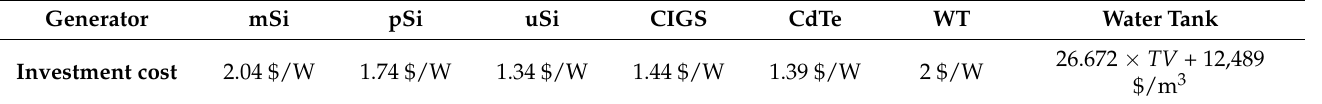
Table 3. Investment costs for the different PV cell technologies, wind turbine and water